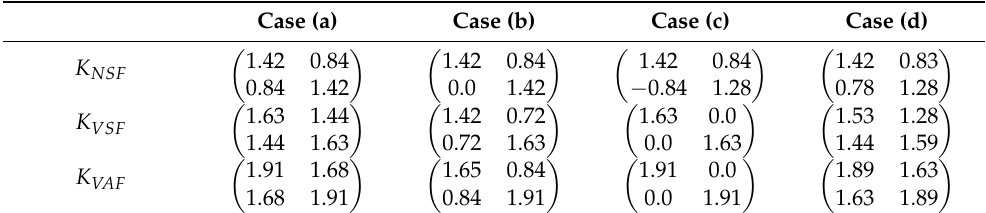
Table 5. Hydraulic conductivity tensors computed on the 2D fracture networks displayed in Figures 22 and